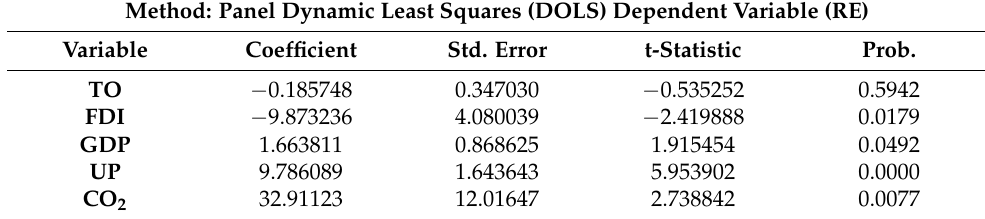
Table 8. Panel Dynamic Least Squares (DOLS) Dependent Variable